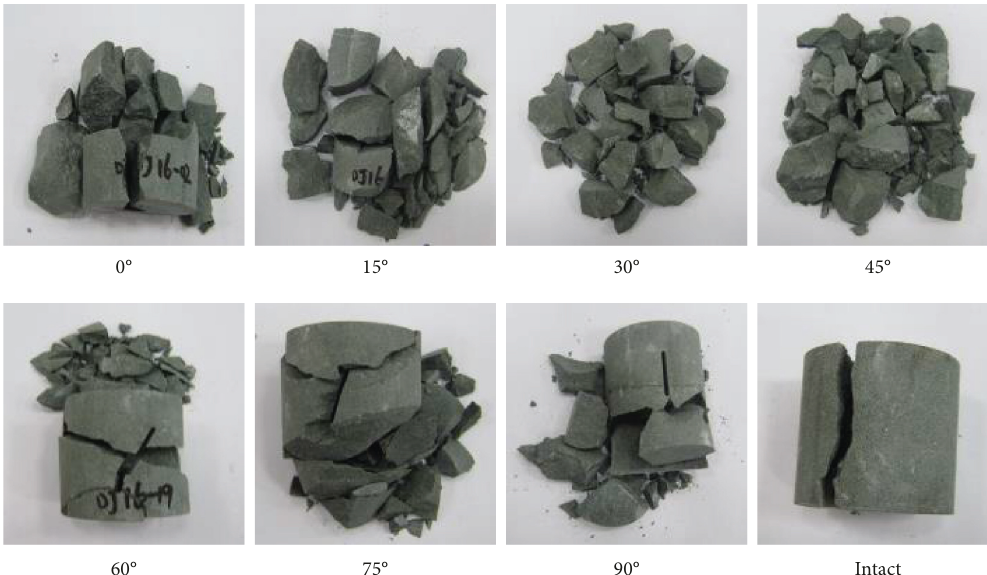
Figure 4: Specimen destruction morphology.